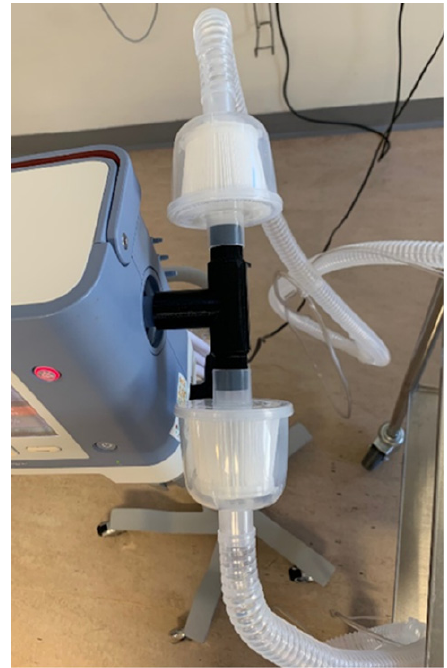
Figure 3. A 3D printed T-Piece Ventilator Splitter connected to a ventilator. This image is